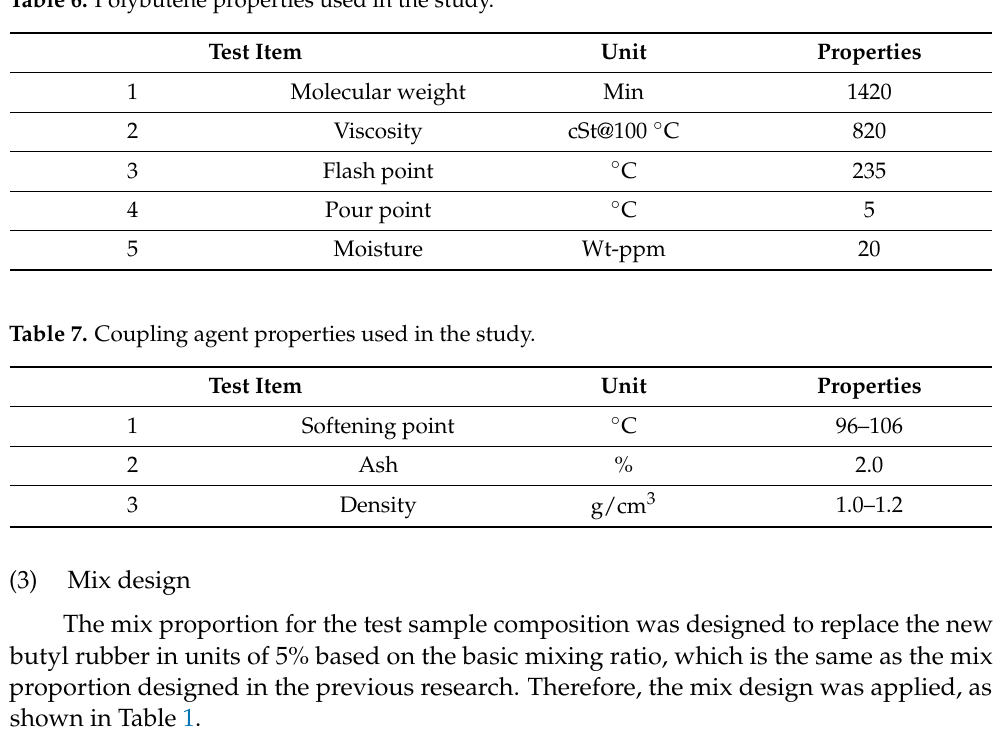
Table 6. Polybutene properties used in the study.